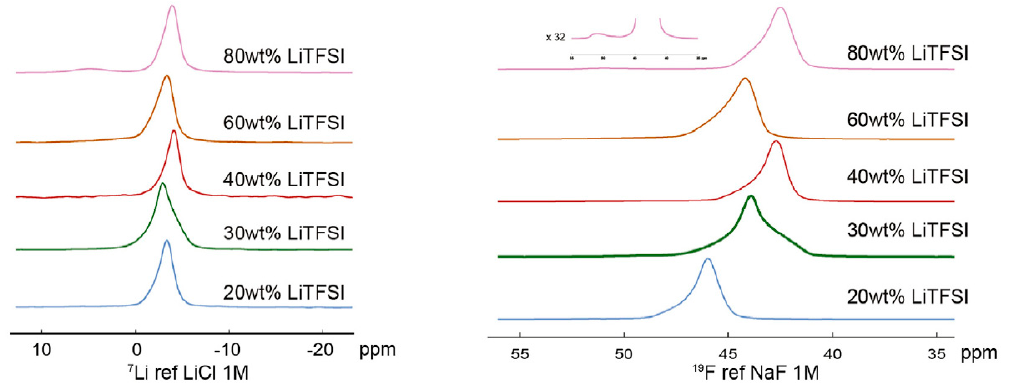
Figure 5. ( left ) 7 Li NMR spectrum of PEO34-PC at 343.15 K of different wt. % LiTFSI samples. ( right ) 19 F NMR spectrum of PEO34-PC at 343.15 K of different wt. % LiTFSI samples [62] Reprinted from [62]. Copyright 2018, with permission from Elsevier.